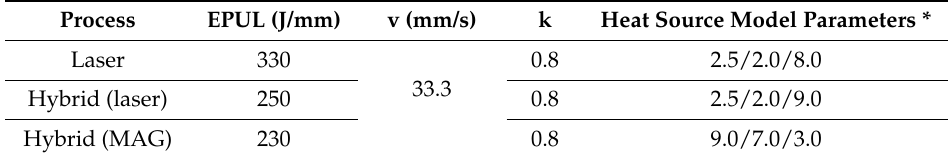
Table 5. Welding parameters used in welding simulations. cooling medium: free air in temperature 20 ◦ C, preheating temperature: 65 ◦